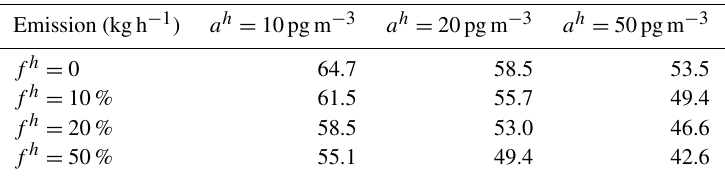
Table 5. Emission strength of release 2 that minimizes F for different f h and a h . Logarithm concentration is taken as the metric variable. ((cid:15) ln (c)